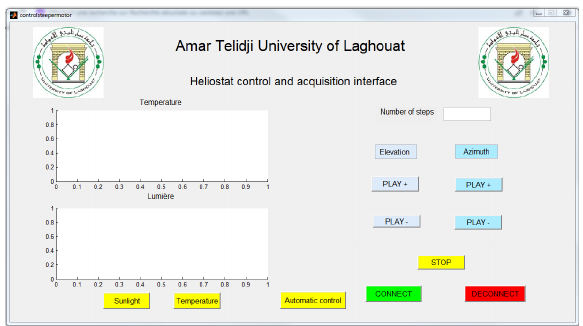
Fig. 5. Control interface of our prototype